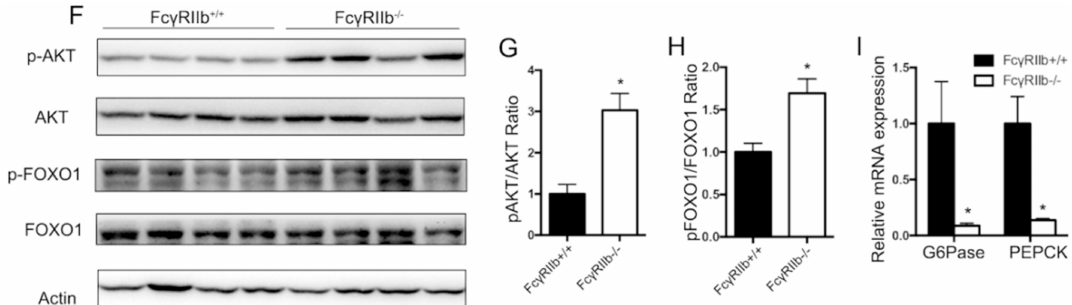
Figure 5. Effect of Fc γ RIIb on AKT phosphorylation. ( A ) HepG2 cells were starved for 18 h before insulin for 30 min insulin treatment. Protein and RNA were collected for western blot and qRT-PCR. Western blot analysis of insulin-induced AKT and FOXO1 phosphorylation after Fc γ RIIb shRNA administration. HepG2 were incubated with 100 nmol/L insulin for 30 min after Fc γ RIIb shRNA or control shRNA administration for 48 h. ( B ) qRT-PCR of mRNA expression of the known downstream genes of FOXO1, G6Pase , and PEPCK . HepG2 cells were treated the same way as described in A. * p < 0.05, between control shRNA and Fc γ RIIb shRNA pretreatment under insulin activation. ( C ) Blood glucose level under fasting condition in HFD fed Fc γ RIIb +/+ and Fc γ RIIb − / − mice. ( D , E ) GTT and ITT assay of HFD fed Fc γ RIIb +/+ and Fc γ RIIb − / − mice. ( F ) Western blot analysis of AKT and FOXO1 phosphorylation in vivo. Fc γ RIIb +/+ and Fc γ RIIb − / − mice were sacrificed and liver were harvested after 16 weeks of HFD. ( n = 4/group). ( G , H ) Statistical analysis of pAKT/AKT ratio and pFOXO1/FOXO1 ratio according to ( F ). ( I ) Relative mRNA expression of G6Pase or PEPCK was analyzed by qRT-PCR from liver of Fc γ RIIb +/+ and Fc γ RIIb − / − mice after 16 weeks HFD administration ( n = 4/group). The data shown are the means ± SEM. * p <